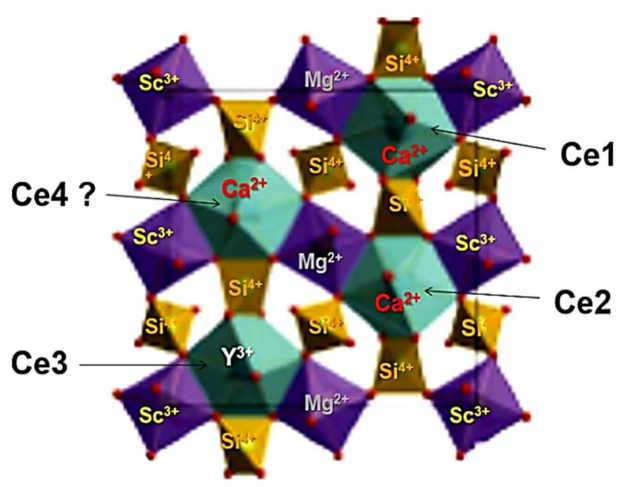
Figure 9. Visualization of possible Ce 3+ multicenter formation in the structure of Ca 2 YMgScSi 3 - O 12 :Ce